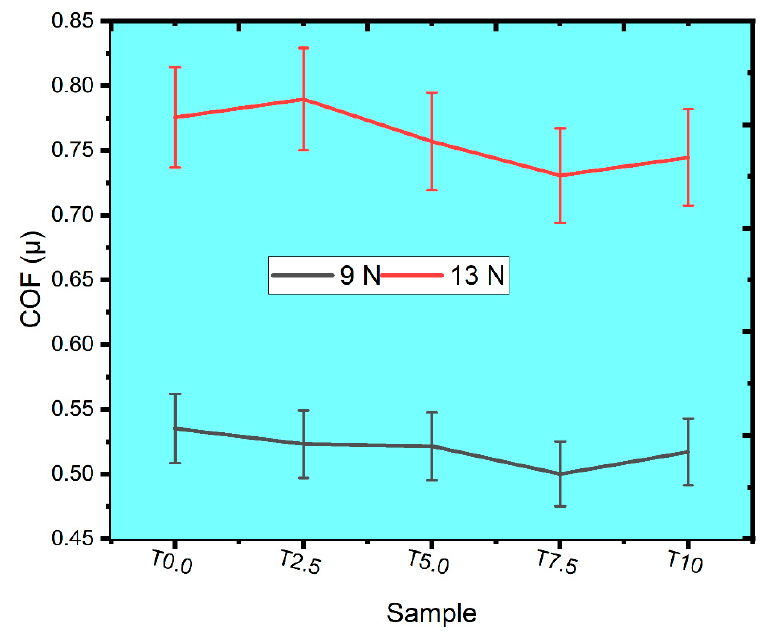
Figure 12. The plot of the mean COF for the sintered samples under 9 N and 13 N loads.